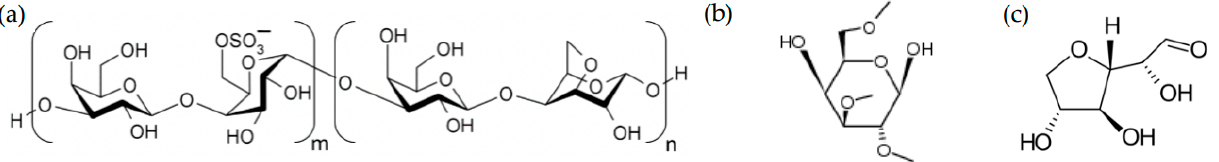
Figure 1. Structural units in porphyran. ( a ) Idealized structure, where the main repeating units are (L-galactose-sulphate ( m ), and D-galactose ( n ) [11]. Residues present: ( b ) methylether and ( c ) anhydrous-L-galactose [7].